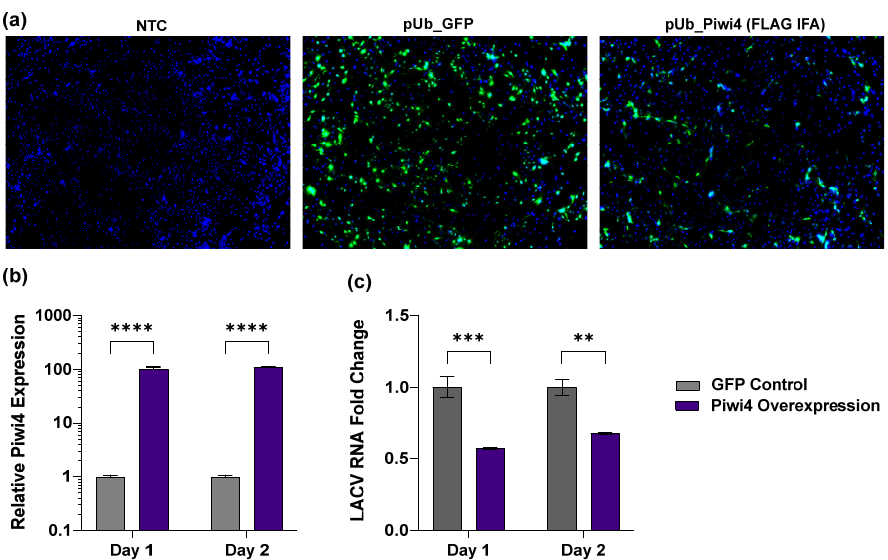
Figure 4. Overexpression of Piwi4 in Cx. quinquefasciatus derived cells. ( a ) Immunostaining with anti-FLAG M2 antibodies in Hsu cells transfected with no plasmid (NTC), pUb_GFP (transfection control), or pUb_Piwi4. ( b ) Relative Cx. quinquefasciatus Piwi4 gene expression (normalized to the Actin 5c housekeeping gene) was determined in pUb_GFP and pUb_Piwi4-transfected cells.